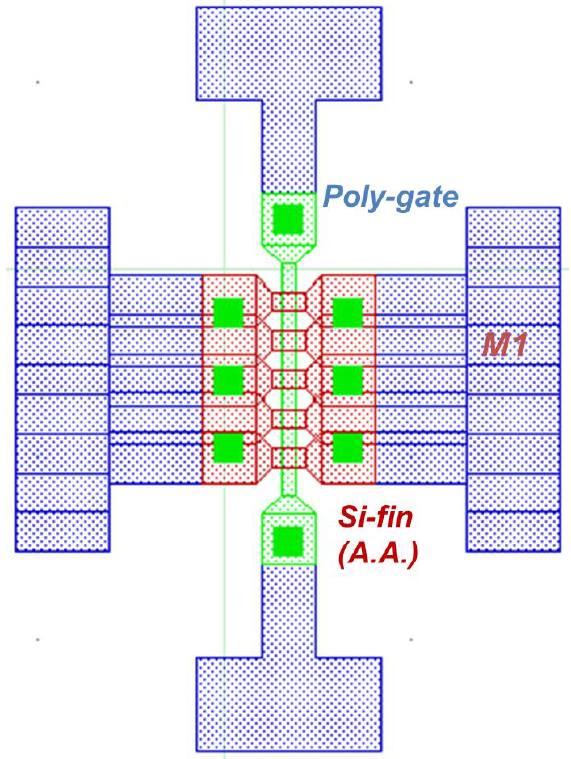
Figure 3. The top-view layout for multiple FinFETs.